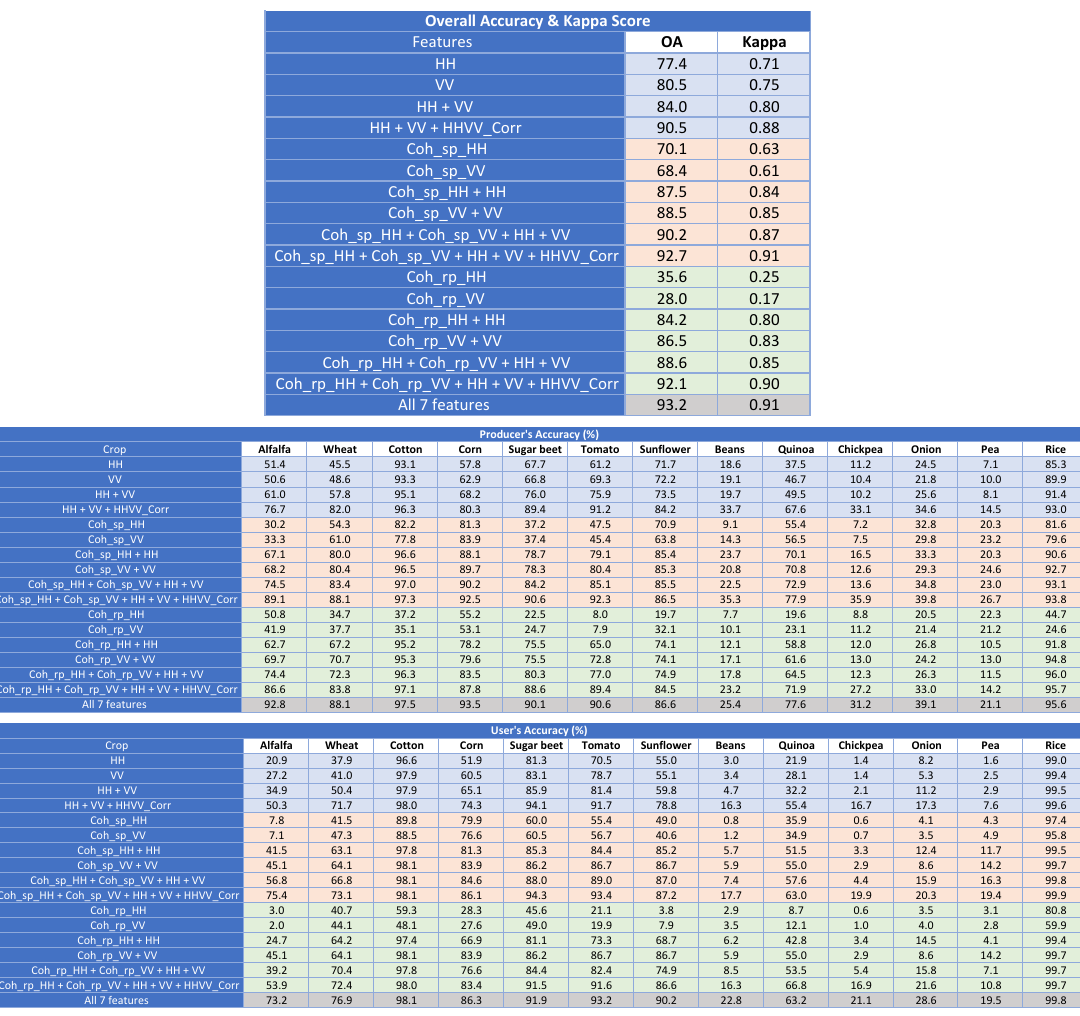
Table 4. Classification scores at pixel level with HH and VV channels. Shading colour: blue for polarimetric features, pink for single-pass interferometric coherence features, green for repeat-pass interferometric coherence features, and grey for all